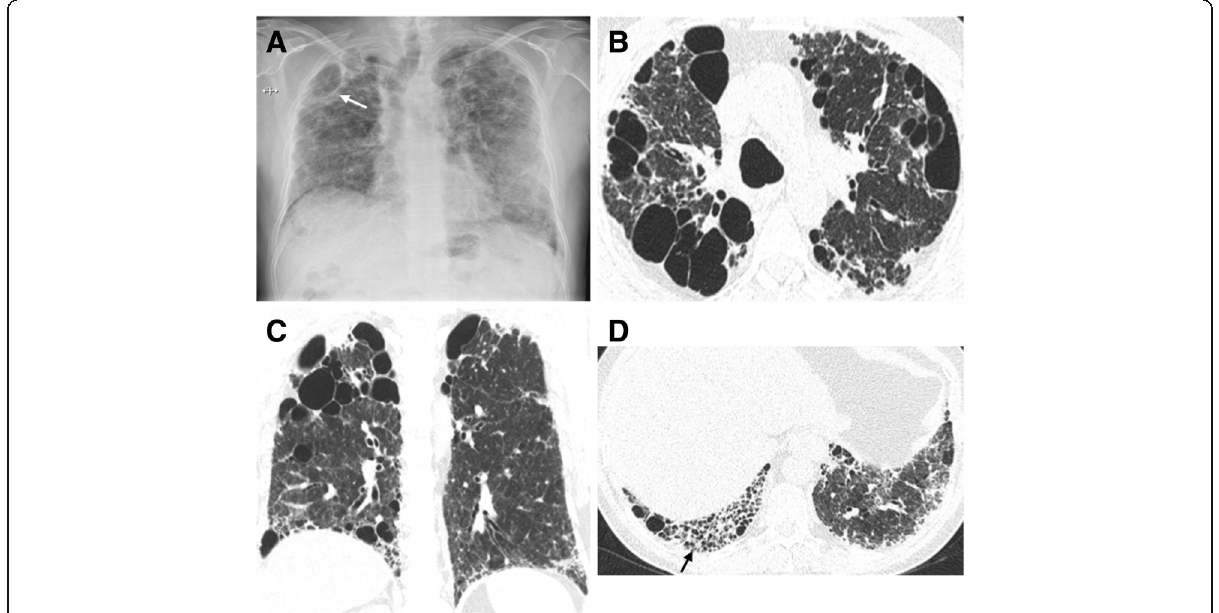
Fig. 20 Combined pulmonary fibrosis and emphysema (CPFE). a Posteroanterior (PA) radiograph shows right volume loss, diffuse bilateral reticular opacities, and GGO. There are lucencies in the upper lobes (white arrow), signifying bullous emphysema. b Axial and c coronal CT images show centrilobular, paraseptal, and bullous emphysema predominantly in the upper lobes. d Axial image through the lower lobes shows peripheral predominant fibrosis with reticulation, traction bronchiectasis, and honeycombing (black arrow), in a UIP